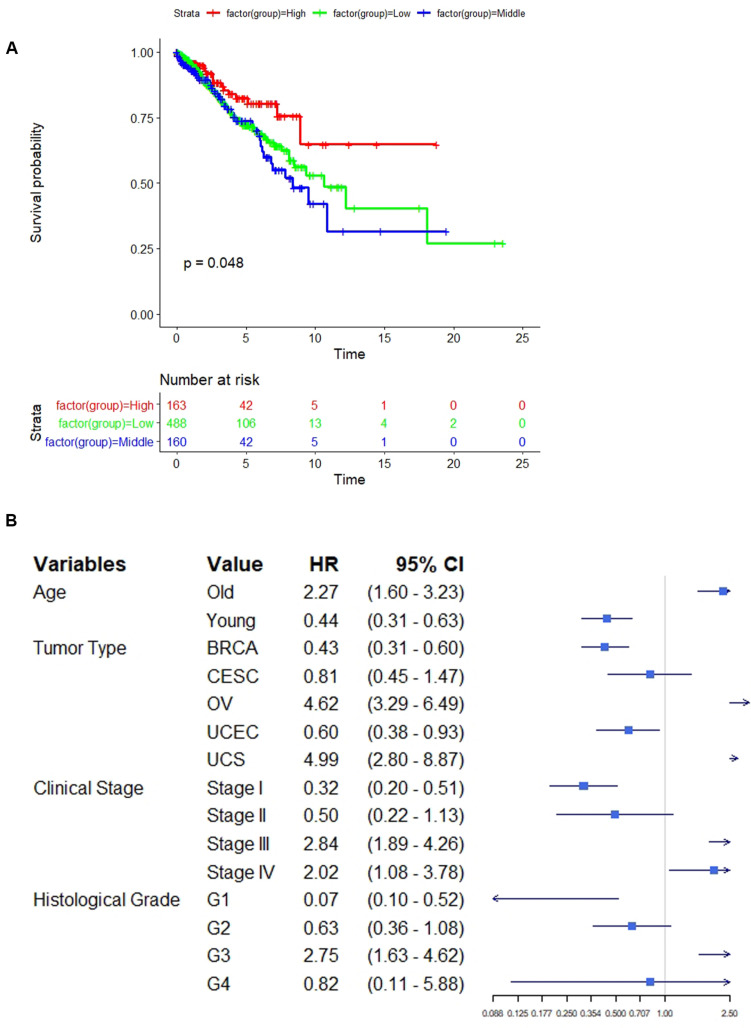
(A) Kaplan–Meier curves of the overall survival time for comparing the three subgroups. (B) The forest plot shows some clinical variables affecting patients’ overall survival.